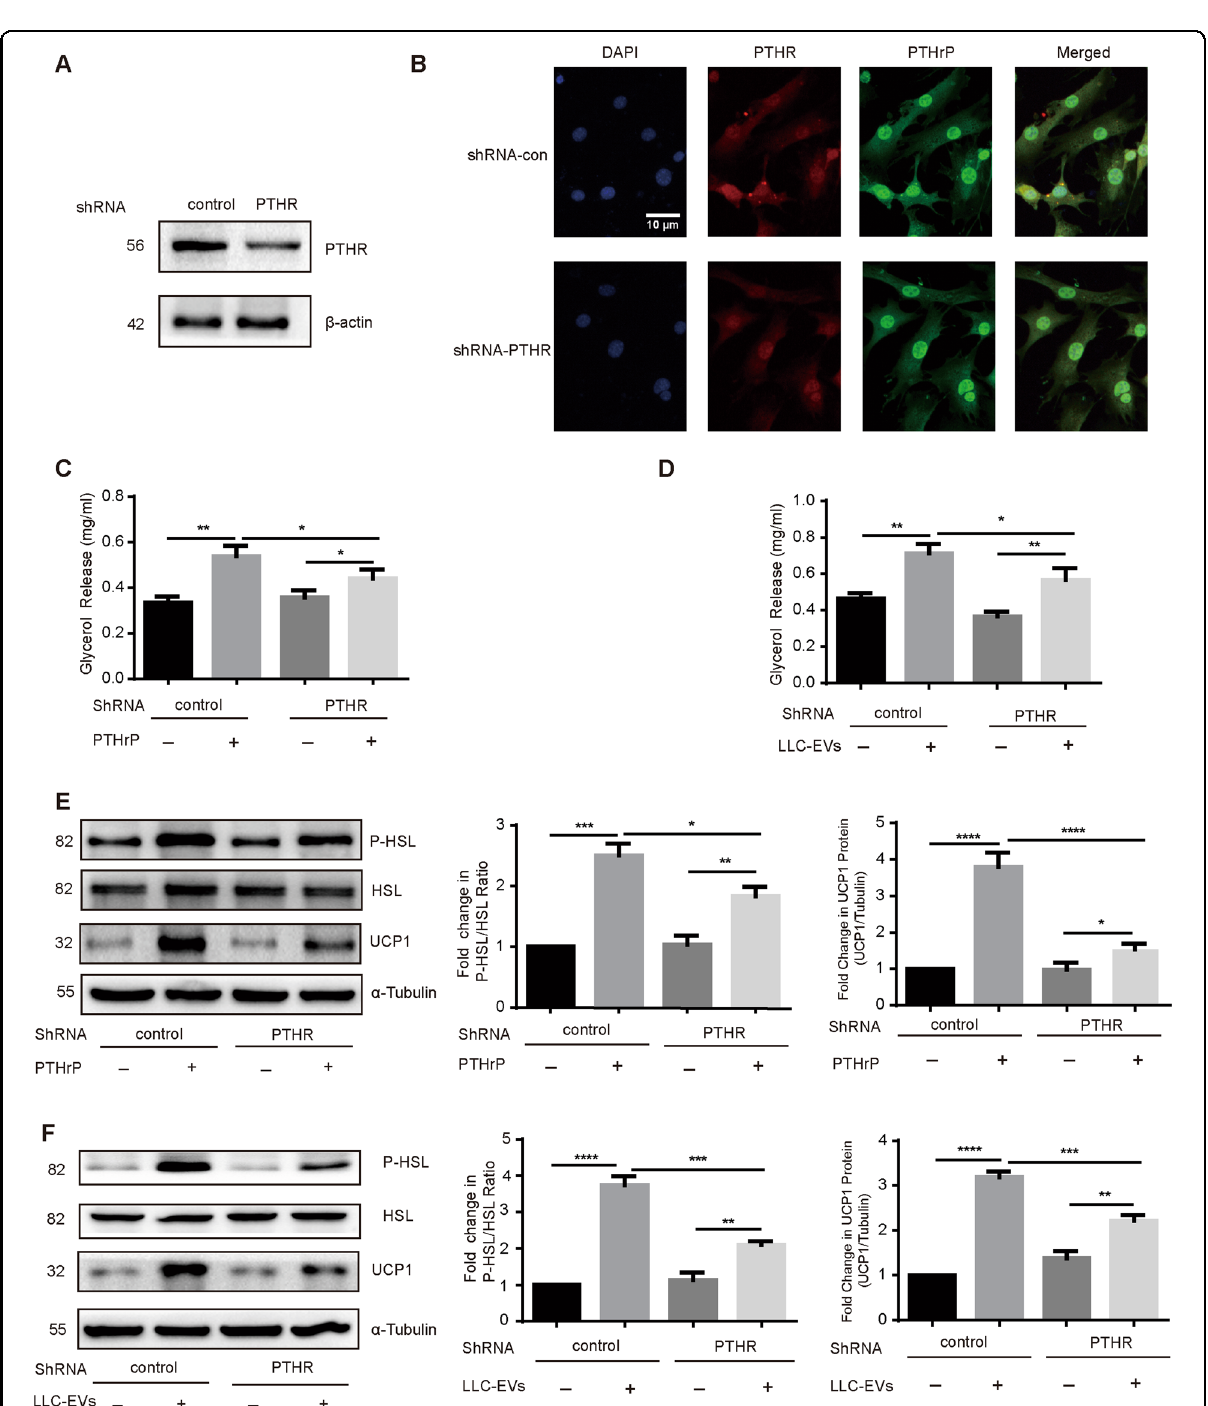
Fig. 4 Lipolysis induced by LLC-EVs was partially dependent on extracellular PTHrP. A Western blotting analysis of the expression of PTHR. B PTHR interactions as assessed by immuno fl uorescence in 3T3-L1 adipocytes: treated with LLC-EVs (10 μ g), and treated with LLC-EVs (10 μ g) from cells transduced with the lentivirus encoding PTHR. Bar = 10 μ m. C , D Glycerol release from 3T3-L1 adipocytes transduced with the lentivirus encoding PTHR or untransduced cells in the presence or absence of PTHrP (100 ng/ml) and LLC-EVs (10 μ g) for 24 h. Data ( n = 4) were analyzed by analysis of variance (ANOVA). E , F Western blotting showing phospho-HSL and HSL in 3T3-L1 adipocytes transduced with the lentivirus encoding PTHR or untransduced cells in the presence or absence of PTHrP (100 ng/ml) and LLC-EVs (10 μ g) for 24 h. Data ( n = 6) were analyzed by analysis of variance (ANOVA). * P < 0.05, ** P < 0.01, *** P < 0.001, **** P <